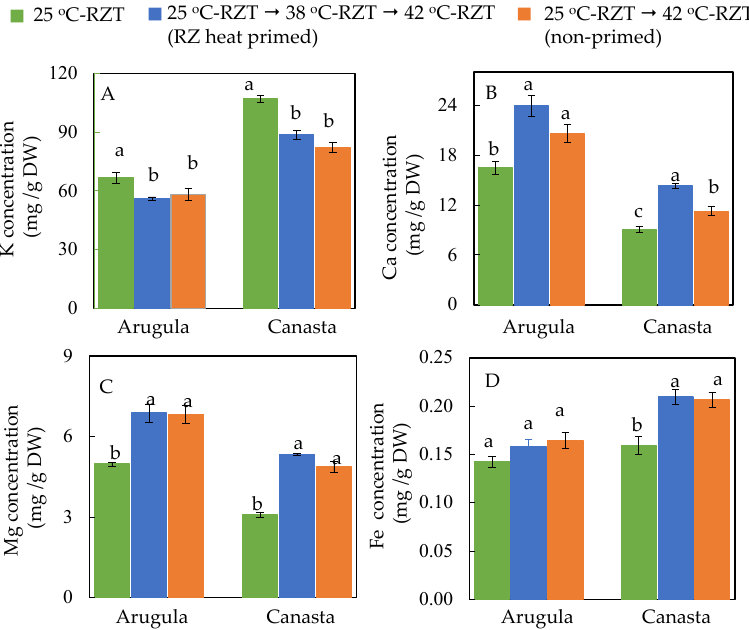
Figure 6. Concentrations of K ( A ), Ca ( B ), Mg ( C ) and Fe ( D ) of Arugula and Canasta at harvest (36 DAT). The vertical lines through the means represent standard errors ( n = 4). Different lowercase letters are statistically different ( p < 0.05, Tukey’s multiple comparison test). Each species was analyzed separately. Refer to Section 4.2 for further details on different RZT treatments.